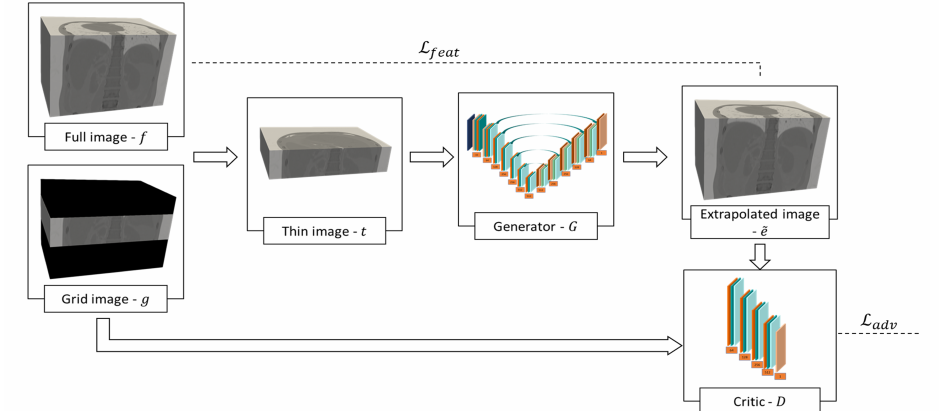
Figure 5. Generator optimization workflow. A conditional GAN was employed in extrapolating thin input volumes, expanding their FOV with a factor of 4.